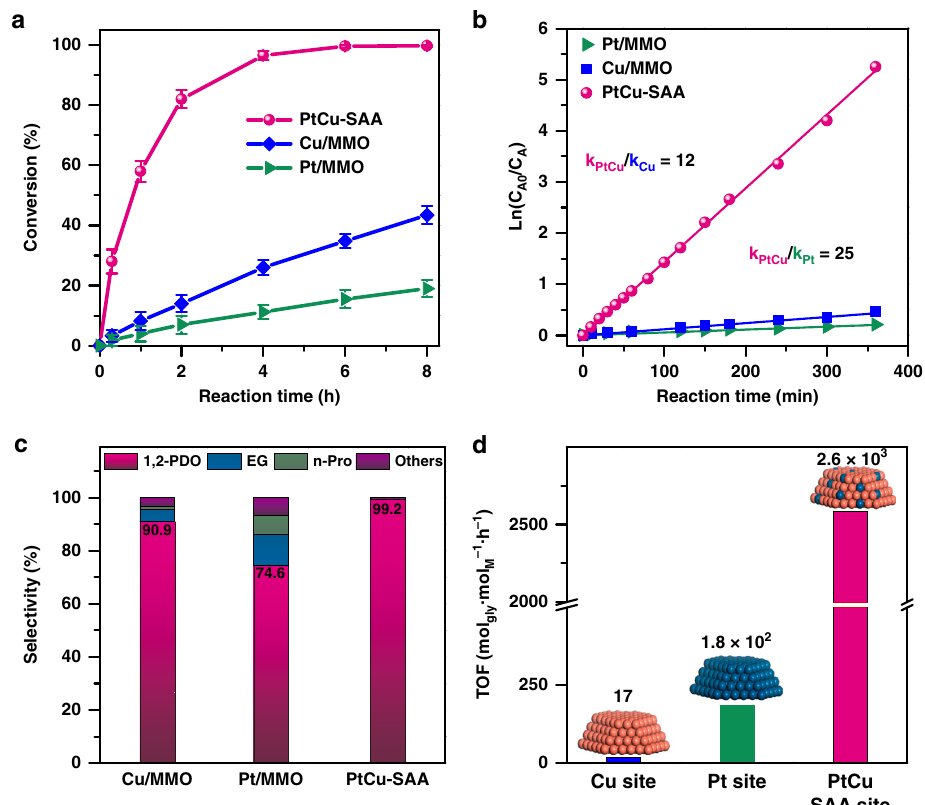
Fig. 5 Reaction studies on glycerol hydrogenolysis to 1,2-PDO. Catalytic evaluation of PtCu-SAA and monometallic catalysts (Pt/MMO and Cu/MMO) toward glycerol hydrogenolysis to 1,2-PDO: a conversion versus reaction time, b ln ( C A0 / C A ) versus reaction time, c the product selectivity, and d the TOF value determined as moles of initial glycerol converted per mole of exposed active sites per hour in the catalytic dynamic range. Reaction conditions: 10 mL of glycerol alcoholic solution (10 wt. %), 0.14 g of catalyst, 200 °C, and 2.0 MPa of H 2 pressure. Error bars were de fi ned as standard deviation, n =